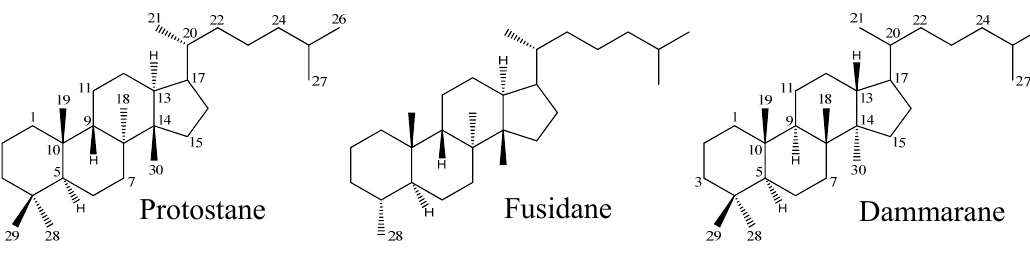
Figure 1. Skeletons of the protostane, fusidane, and dammarane